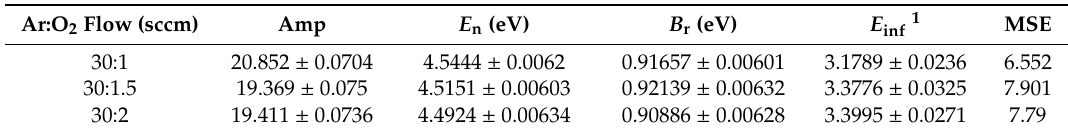
Table 2. The values of Gauss parameters and MSE obtained by fitting the experimental data with a single